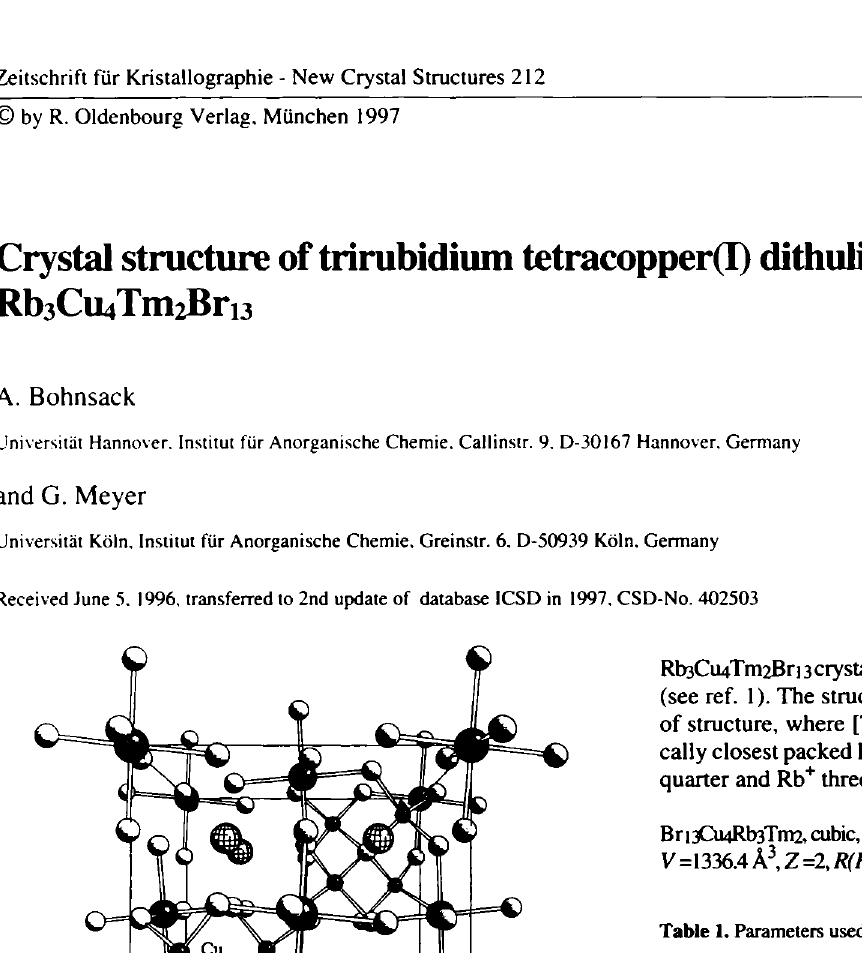
Table 1. Parameters used for the X-ray data collection Crystal: